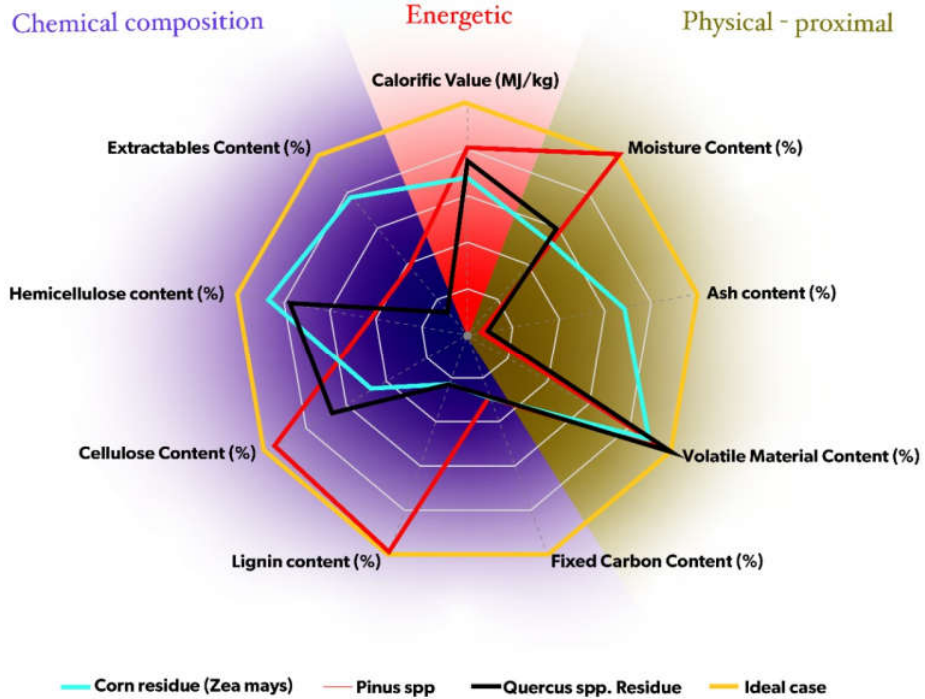
Figure 3. Formulation of indicators with different parameters.